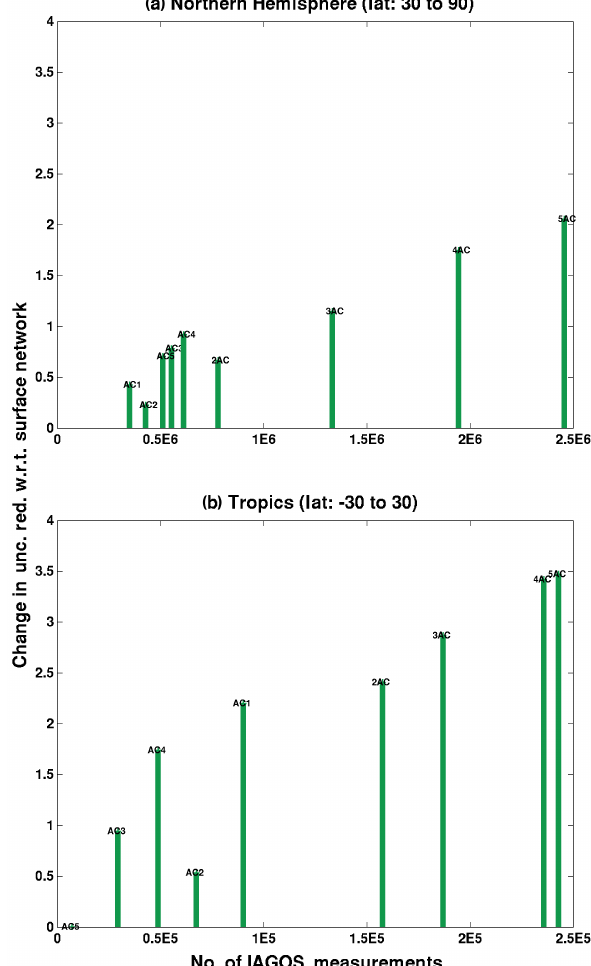
Figure 6. Plots showing change in uncertainty reduction (with re- spect to the surface network) against the number of measurements from IAGOS aircraft for the (a) Northern Hemisphere and (b) trop- ics. ACi ( i = 1 to 5) refers to the simulation using measurements from aircraft number i . jAC ( j = 2 to 5) refers to simulations that use measurements from j number of aircraft. Note that the scaling of the x axis differs by a factor of 10 between (a) and (b)